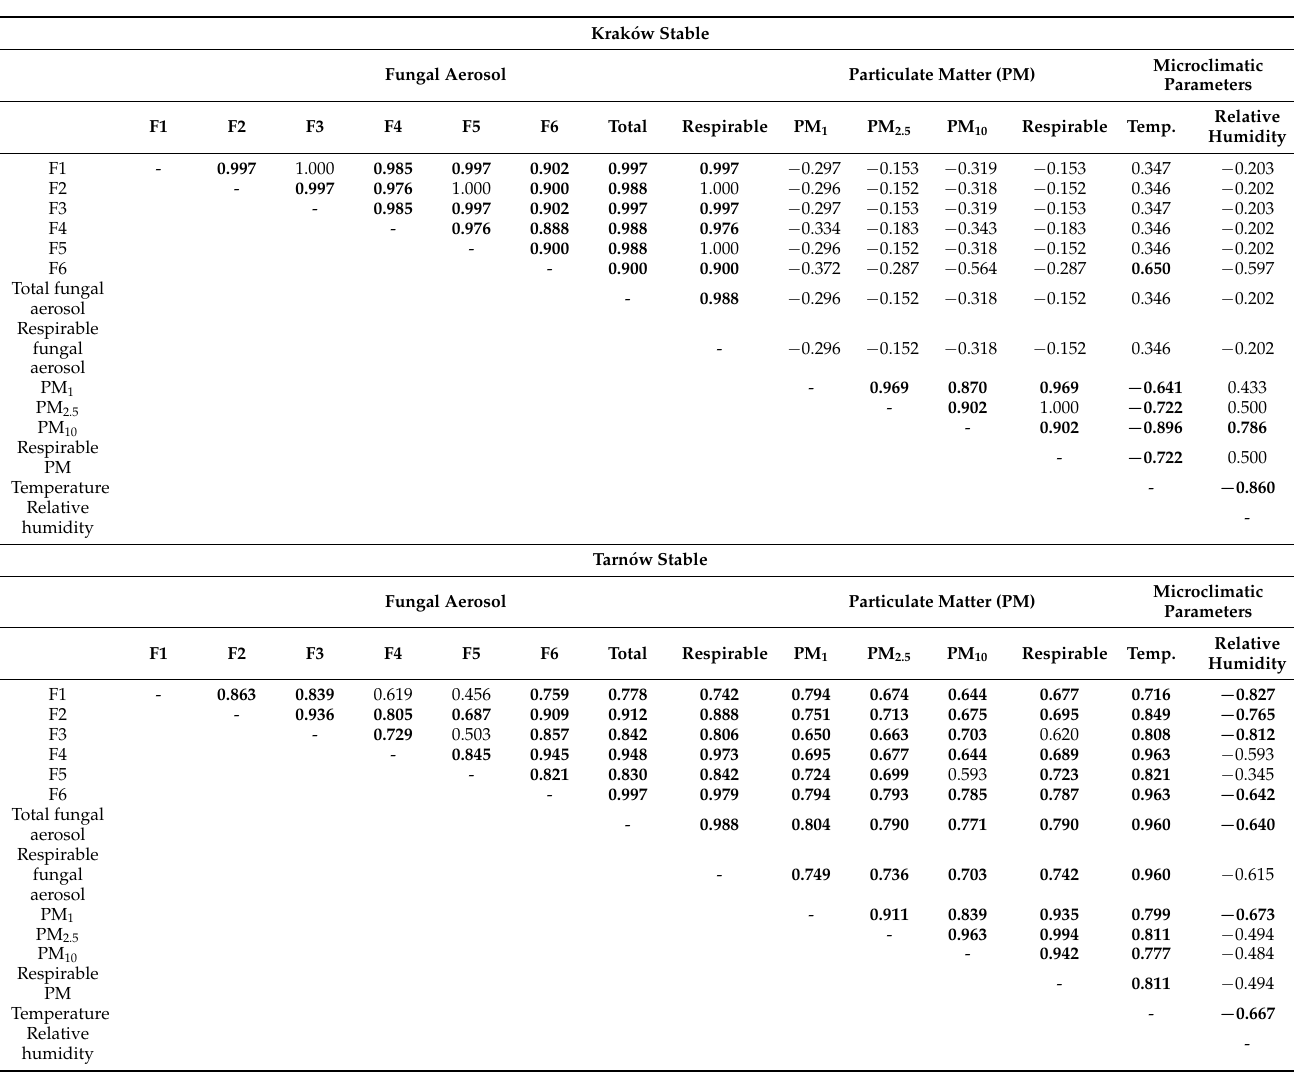
Table 3. Spearman’s correlation coefficient matrix for microbial bioaerosol components, PM fractions, temperature, and relative humidity of air. Bolded values are significant at p <